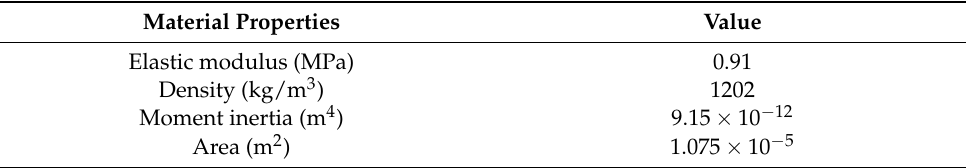
Table 9. Material properties of rubber (gutta-percha).